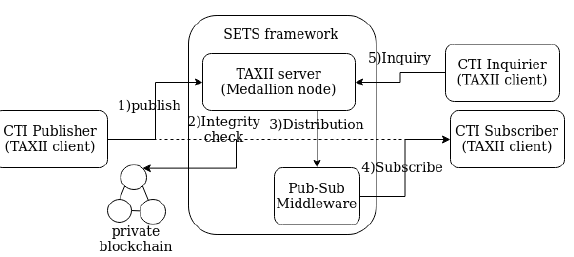
Figure 2. Architecture of the SETS framework. The figure depicts the key components of the prototype. The step numbers match Figure